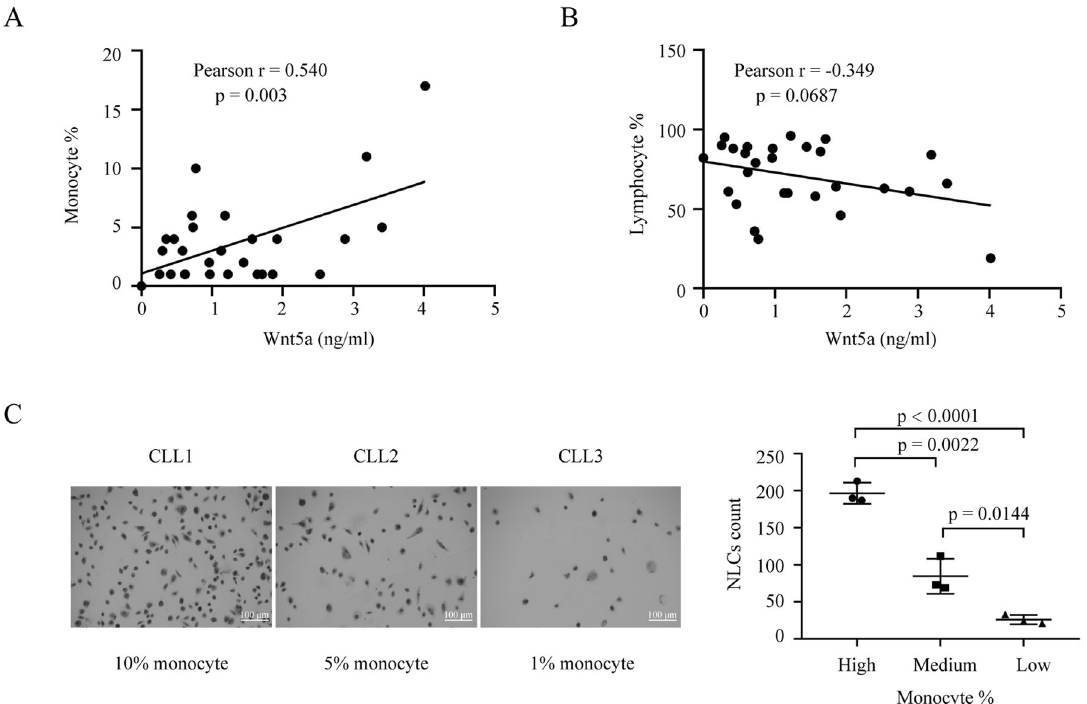
Fig. 1 Monocyte-derived NLCs correlate with Wnt5a levels in plasma from CLL patients. A , B The concentration of Wnt5a in plasma of patients positively correlates with their monocyte percentage in whole white blood cells ( A n = 28, Pearson correlation = 0.540, p = 0.003), but not their lymphocyte percentage ( B n = 28, Pearson correlation = − 0.349, p = 0.0687). C Wright – Giemsa staining of NLCs cultured from PBMCs of patients with CLL with different monocyte percentage. Dot fi gures represent numbers of NLCs in the fi eld (40X) of each group. Error bars denote standard deviation ( n =